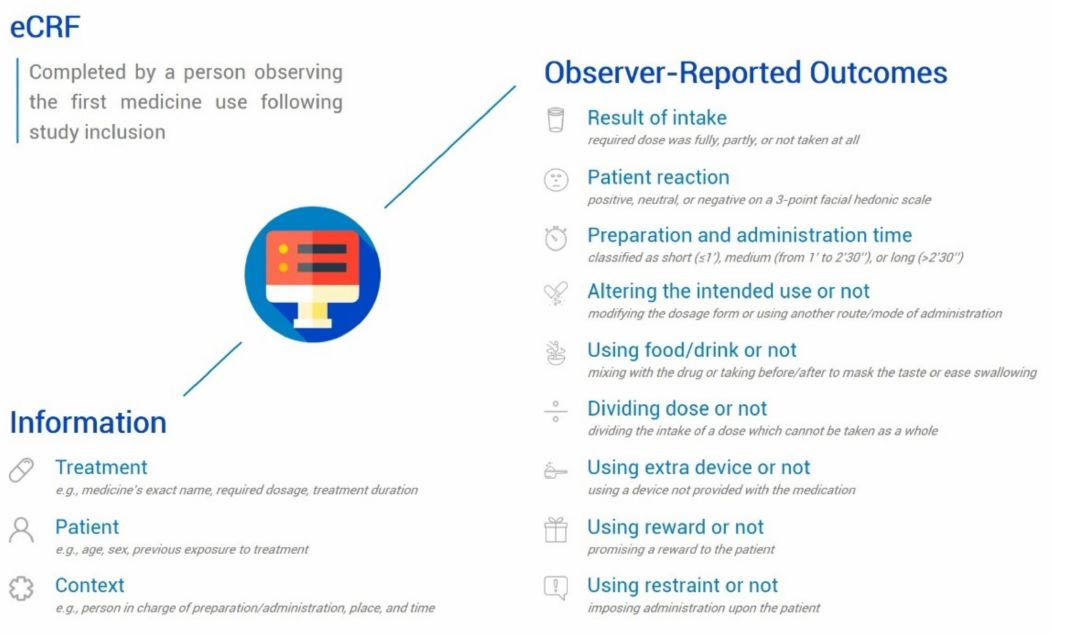
Figure 1. Data collection